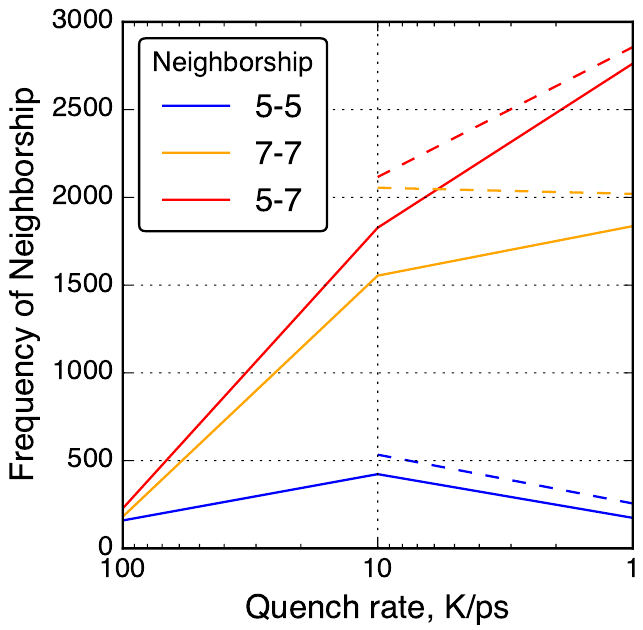
Figure 5. Neighbor–neighbor relationships between 5- and 7-membered rings in QMD-generated models. Solid lines connect data from simulations without post-quenching compression and dashed lines connect data from simulations with post-quenching